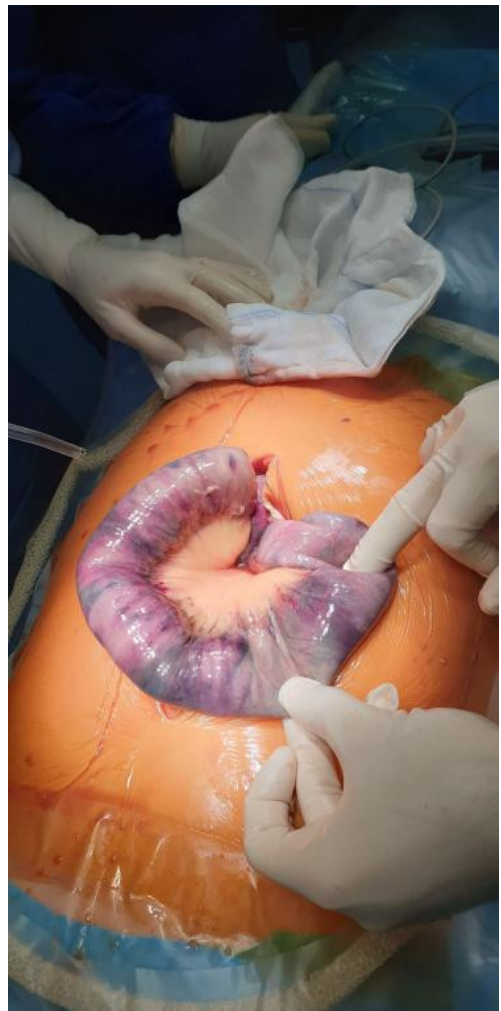
Figure 3. Intraoperative image taken during an explorative laparotomy. The photograph reveals necrosis of the stomach and small intestine. Due to the severity of necrosis, surgical treatment was abandoned. The patient died the following day from multi-organ failure.